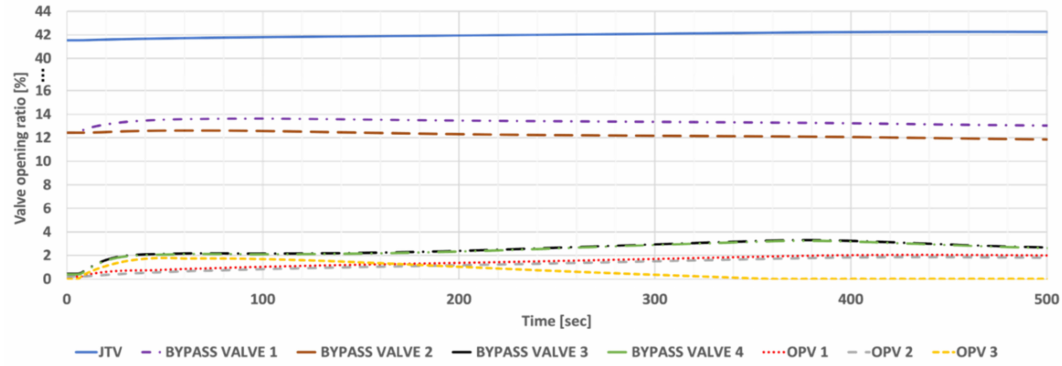
Figure 22. Valve opening ratio when one engine is tripped.